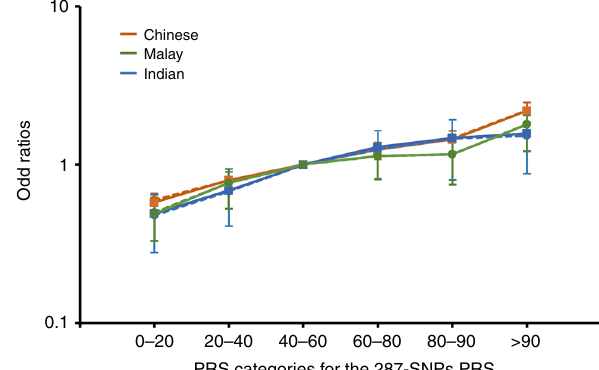
Fig. 4 Association between percentiles of 287-SNP polygenic risk scores and overall breast cancer risk in Chinese, Malay and Indian women from Malaysia and Singapore. Results were generated using 5236/5516 Chinese cases/controls, 1084/1332 Malay cases/controls and 580/1018 Indian cases/controls from Malaysia Breast Cancer Genetics (MyBrCa) and Singapore Breast Cancer Cohort (SGBCC) studies, strati fi ed by ethnicity. The squares represent the odds ratios (ORs) and the vertical lines represent the corresponding 95% con fi dence intervals, with middle quintile (40 – 60th) as the reference category. Solid lines represent the observed ORs and dashed lines represent the predicted ORs of PRS under a multiplicative polygenic model. Source data are provided in Supplementary Table